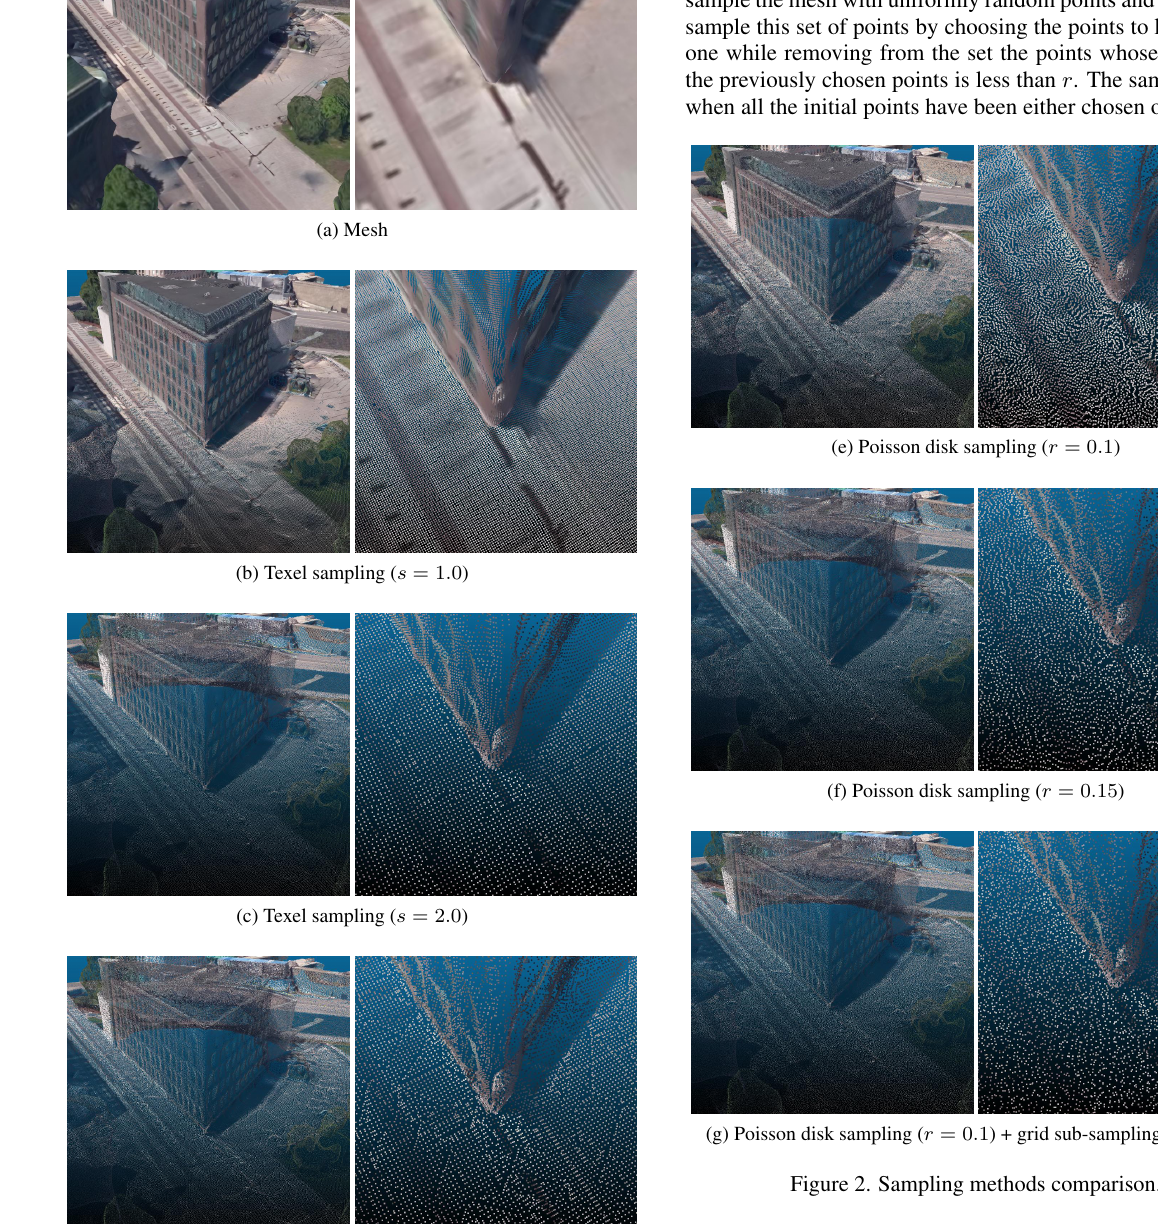
Figure 2. Sampling methods